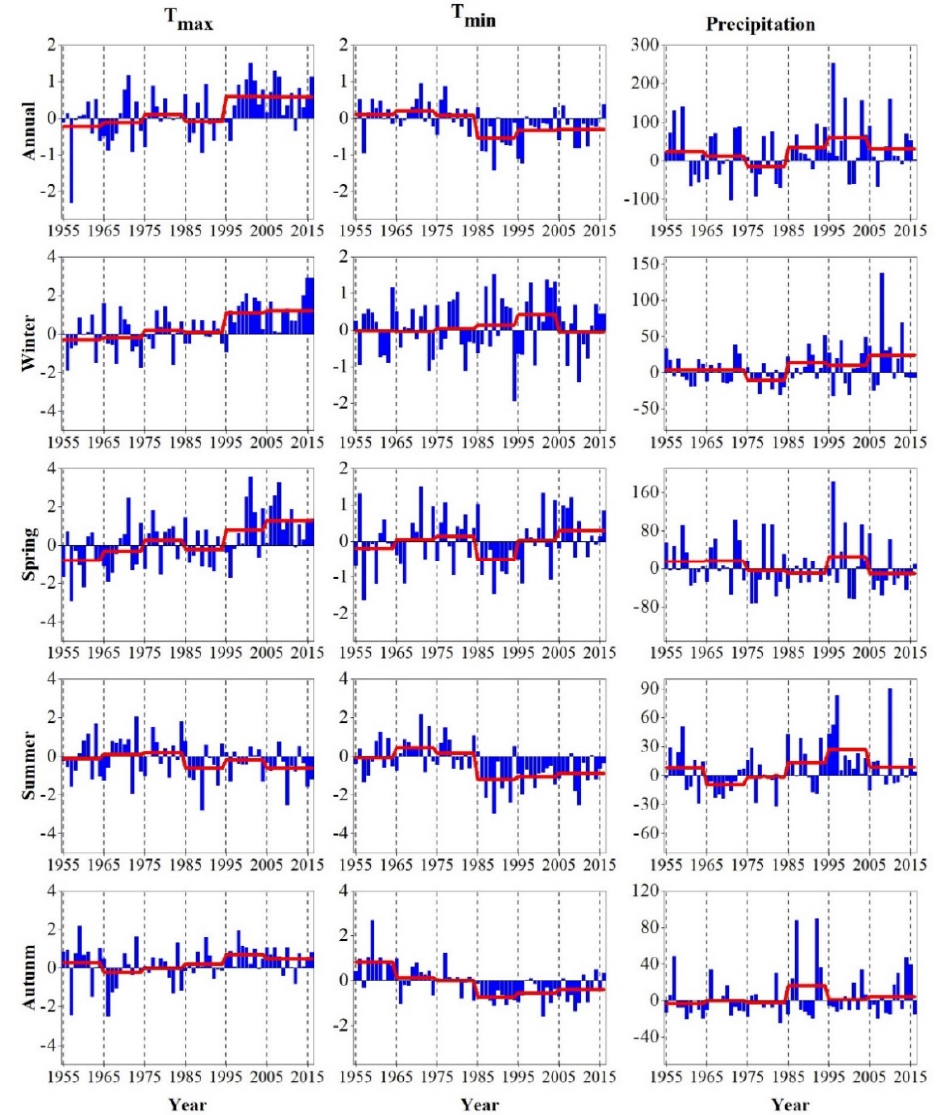
Figure 5. Annual and seasonal time series anomalies relative to 1961–1990 mean values for T max , T min and precipitation, while smooth line indicates decadal means to the long-term mean.